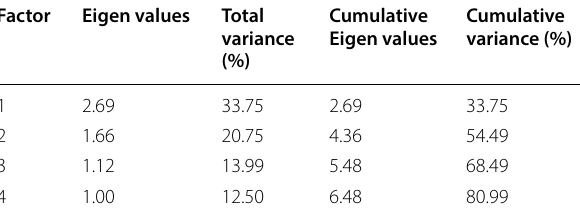
Table 6 Total variance explained for subsurface samples Factor